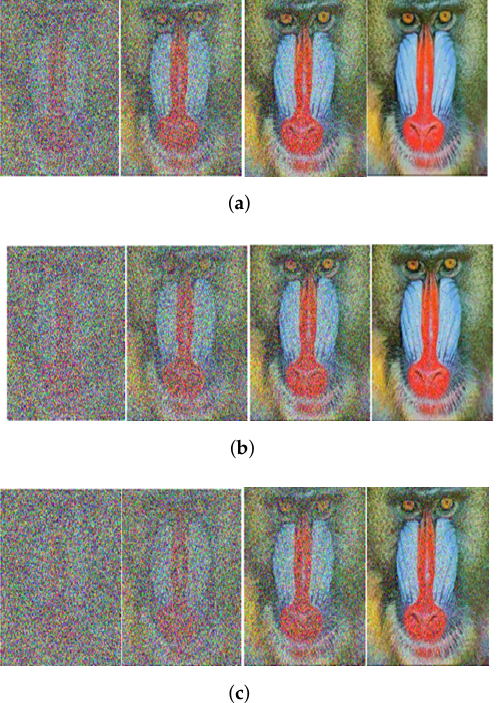
Figure 14. Received image with massive MIMO incorporated FRFT-OFDM over a Rayleigh channel, Modulated with 32-PSK and at SNR = 0, 10, 20, 30 dB from Left to Right for different number of users, n . ( a ) n = 10; ( b ) n = 20; ( c ) n = 50.